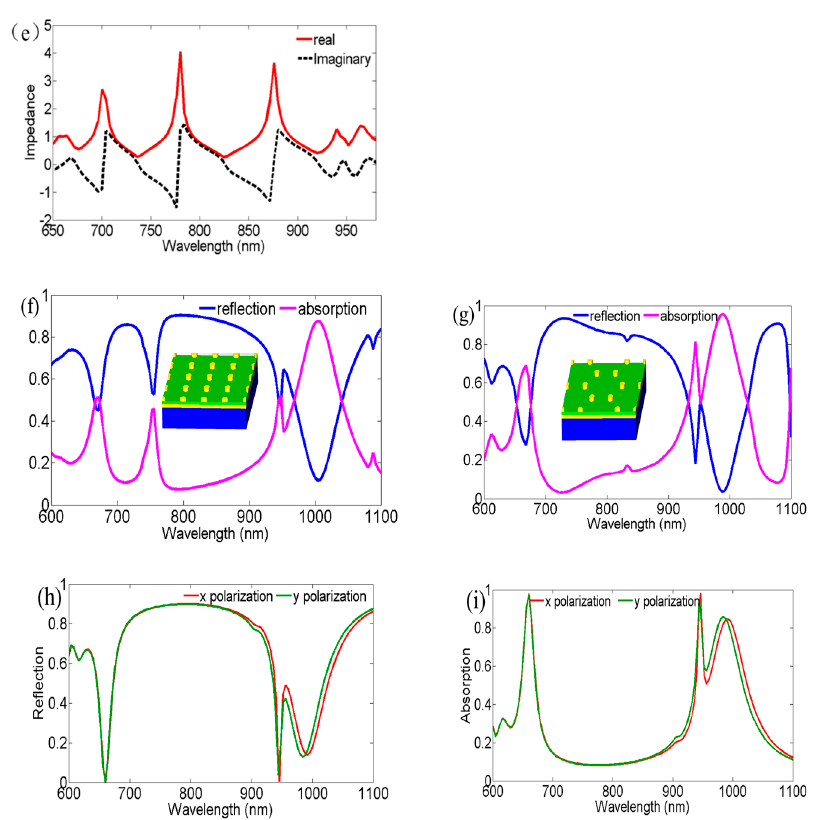
Figure 1. Schematic view and optical properties of the hexagonal nanodisk array layered structure under normal incidence. ( a ) Three-dimensional view of the designed layered structure and its structural parameters; ( b ) top cross-section of the designed structure. Calculated spectra for ( c ) reflection and ( d ) absorption with structure parameters ( P, D, h 1 , h 2 , H ) = (700, 200, 50, 50, and 40 nm) by finite element method and finite-difference time domain simulation, respectively; ( e ) real part and imaginary part of the retrieved relative effective impedance in discussed wavelength regions. Calculated reflection (blue line) and absorption spectra (pink line) for ( f ) square nanodisks array and ( g ) honeycomb-like nanodisks array with the same structure parameters as that of discussed hexagonal nanodisks array structure. Insets of Figure 1f,g show the schematic views of square array and honeycomb-like array, respectively. The influence of changing polarization directions onthe ( h ) reflection and ( i ) absorption spectra.